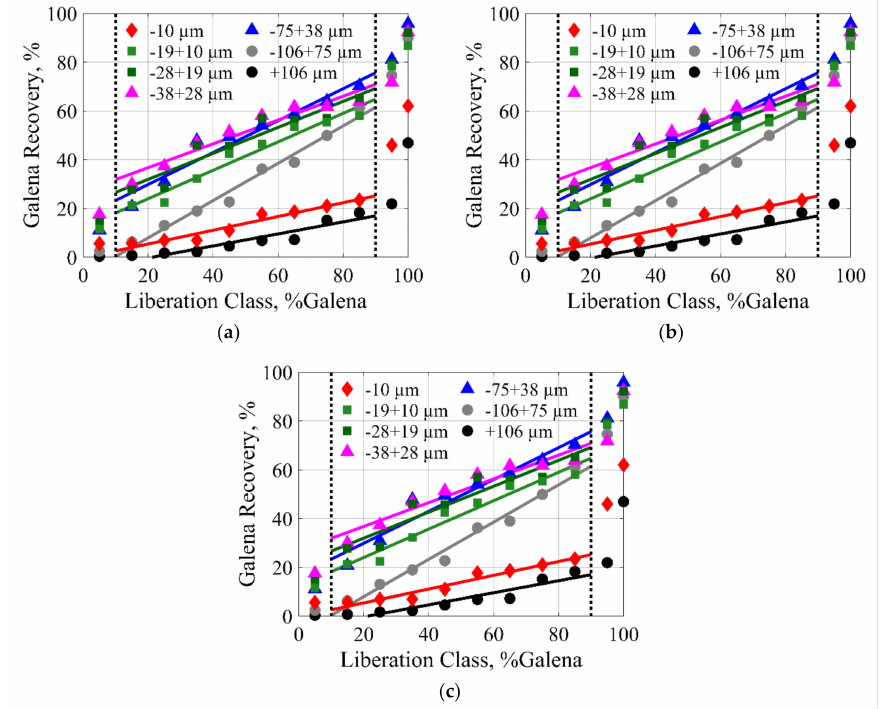
Figure 1. Galena recoveries versus liberation: ( a ) Vianna [8] 15 g/ton of Aerophine 3418A, ( b ) Savassi [13] 10 cells in series, and ( c ) Welsby [9] 15 g/ton of Sodium Ethyl Xanthate Experi- mental data are presented as datapoints and model fitting as the trend line. The vertical lines define the validity range for the linear